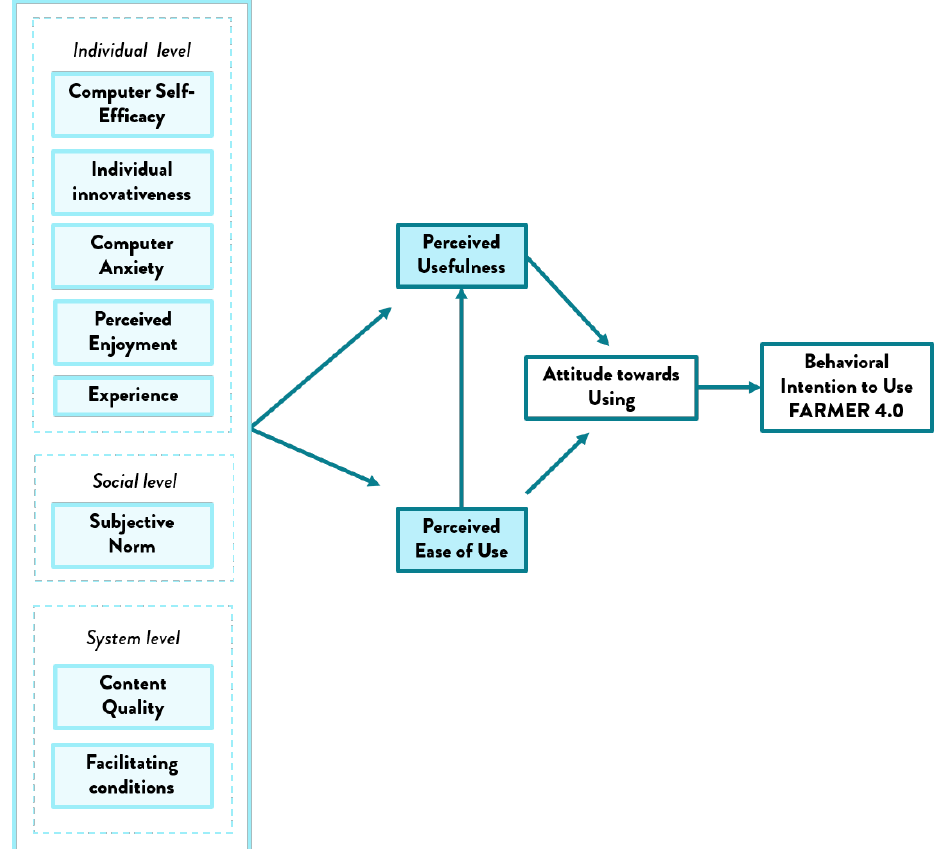
Figure 9. Proposed TAM extension for FARMER